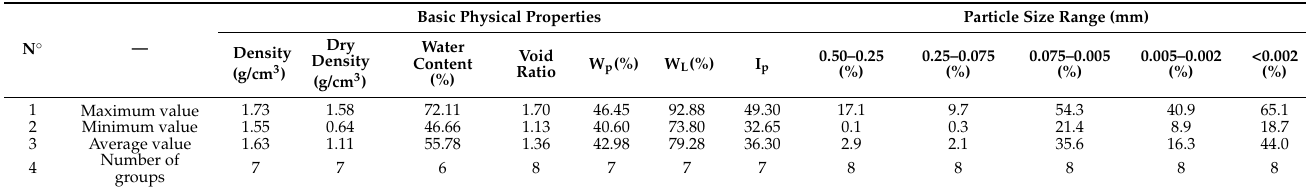
Table 2. Basic physical properties and particle analysis of diatomaceous earth.